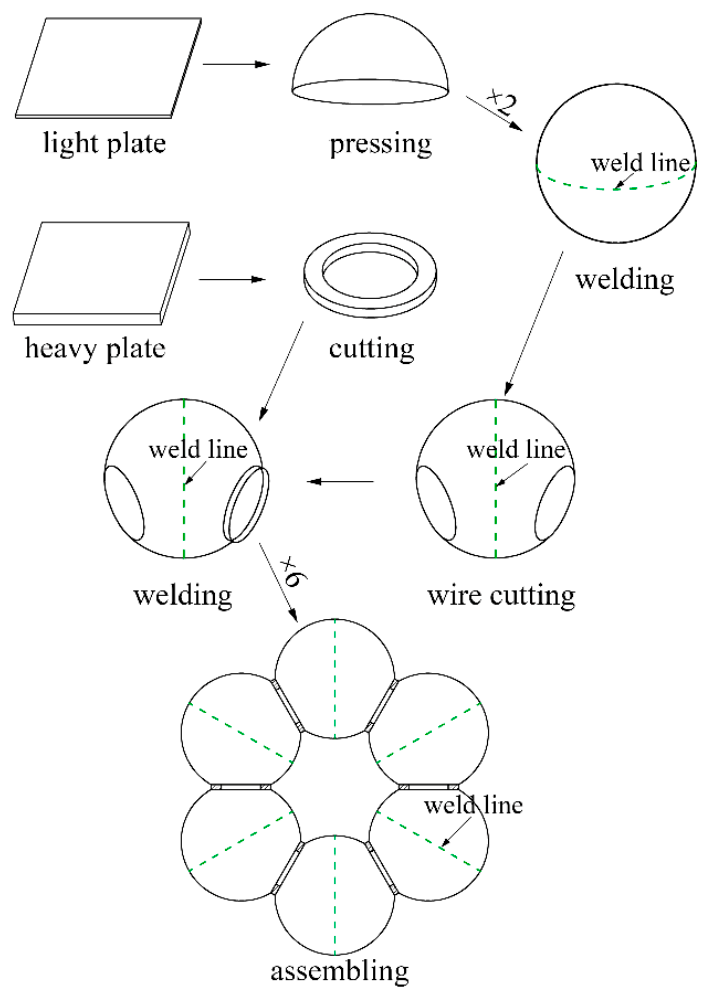
Figure 2. Schematic of the process for manufacturing sphere-segmented toroidal shells.